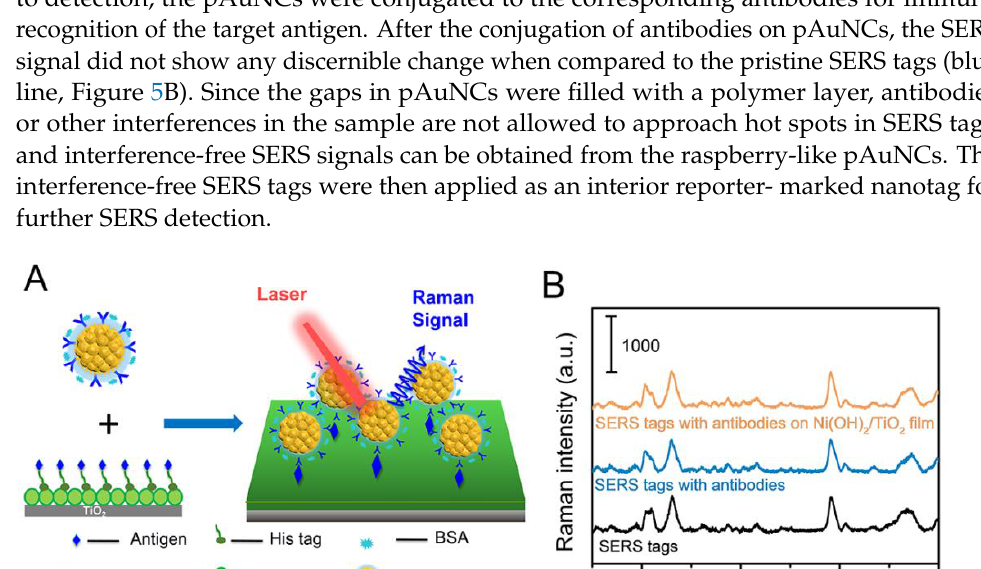
Figure 4. ( A ) SRES spectra of pAuNCs with different concentrations and ( B ) the corresponding signal intensity at 518, 1168, and 1661 cm −1 . ( C ) SERS spectra of pAuNCs collected from 10 random spots and ( D ) the corresponding signal intensity at 1168 cm −1 .